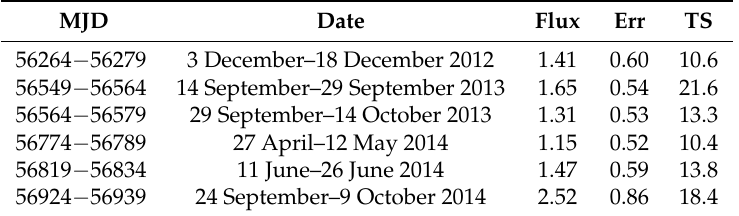
Table 1. γ -ray detections of 3C 120 in the energy range 0.5–100 GeV as we obtained from the 15 days-bin analysis. We report the integration time in MJD and date, the flux with the corresponding error in 10 − 8 photon cm − 2 s − 1 and the TS value associated with each γ -ray detection.